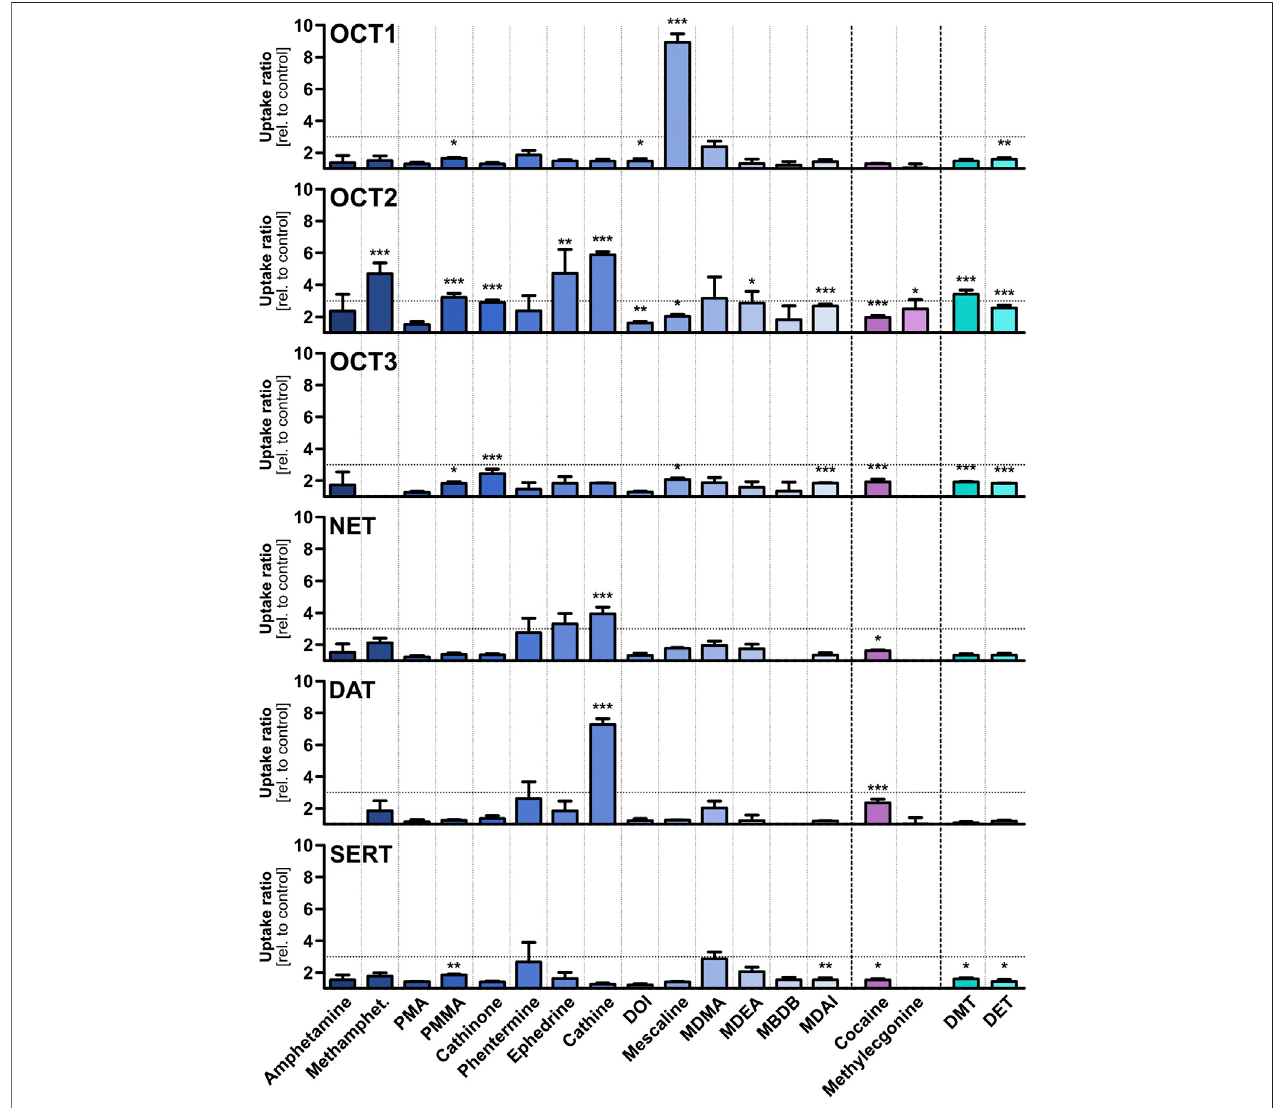
FIGURE 3 | Transport of different psychostimulant and hallucinogenic substances at a concentration of 1 µM by OCTs and high-af fi nity monoamine transporters, shown as the ratios of uptake after 2 min in transporter-transfected cells over empty vector control cells. Shown are the mean values of ≥ 3 independent experiments +SEM. The horizontal dotted line indicates an uptake ratio of 3, which was set as the minimum threshold for more detailed characterisation. Statistical signi fi cance over empty vector control cells was determined using Student ’ s t-test with * p < 0.05, ** p < 0.01, and *** p < 0.001.